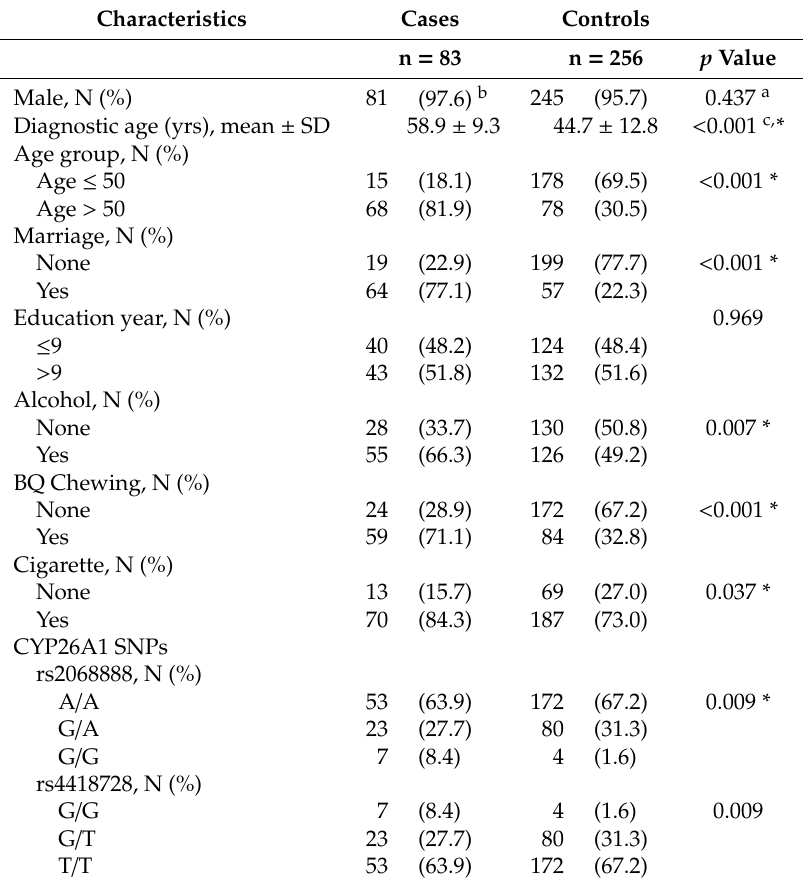
Table 1. Characteristics of the oral and pharyngeal cancers and controls (n =